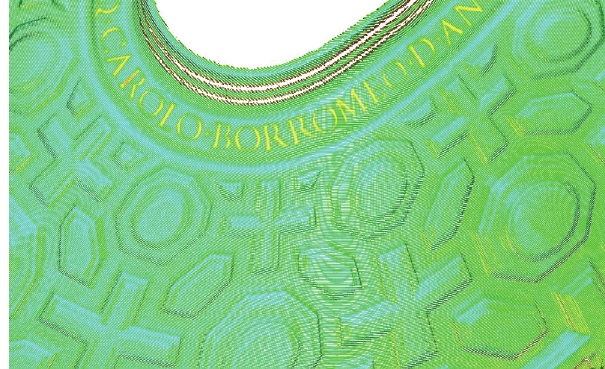
Figure 5. Portion of range based model (reflectance image)